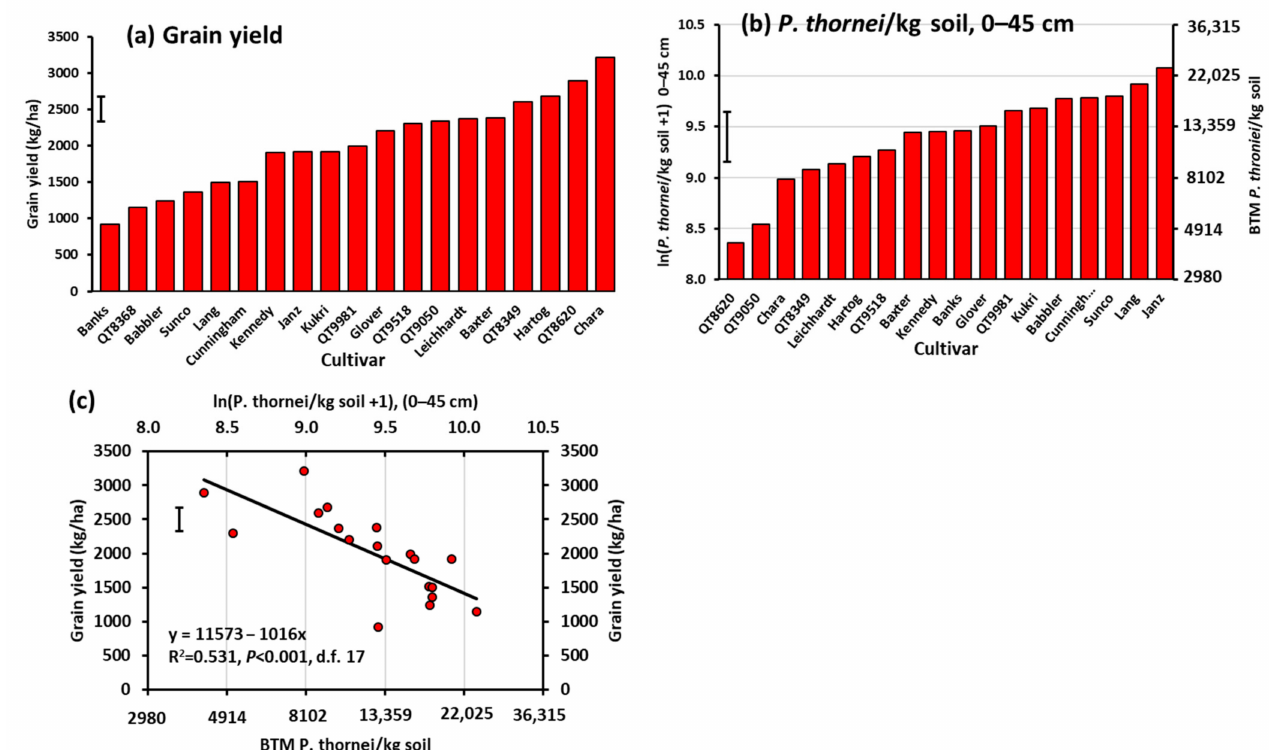
Figure 4. ( a ) Grain yield of 19 wheat cultivars in Experiment 2, ( b ) mean ln( P. thorneiI /kg soil +1) of final population densities in in the soil profile to 45 cm depth after harvest, and ( c ) regression relationship between yield and P. thornei population density. Cultivars are in ascending order of value on the Y -axis in ( a , b ). BTM = back-transformed mean. Bar markers represent the l.s.d. ( p =